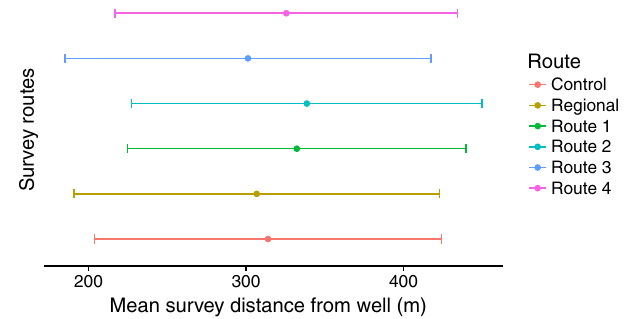
Figure 3. Mean distance from infrastructure while surveying each of the six routes listed in Fig. 1. One standard deviation from the mean shows the range of distances at which we were sampling downwind of